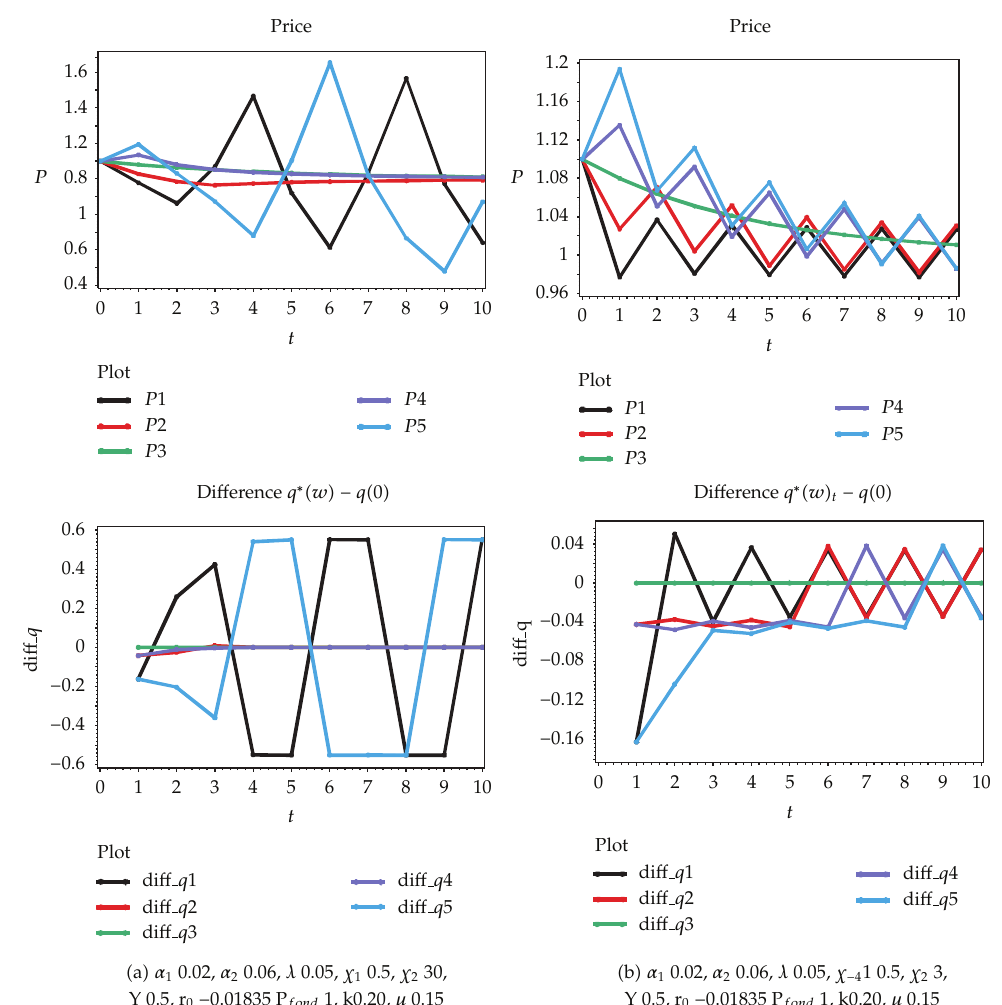
Figure 12: Plot of time evolution of some variables (cid:3) mixed case (cid:6)